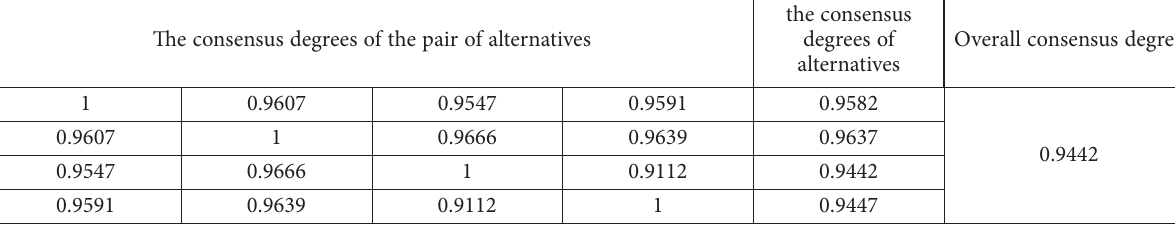
Table 7. Different kinds of consensus